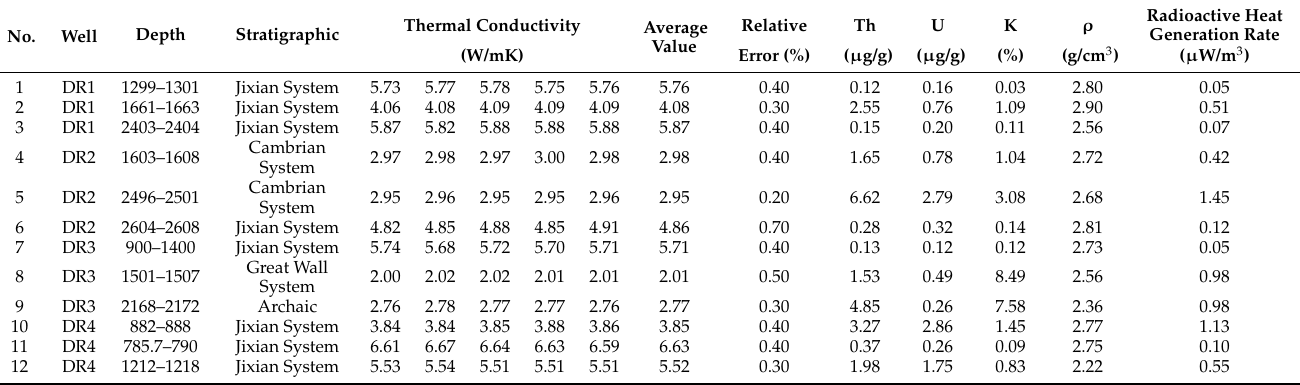
Table 4. Rock thermal properties results.